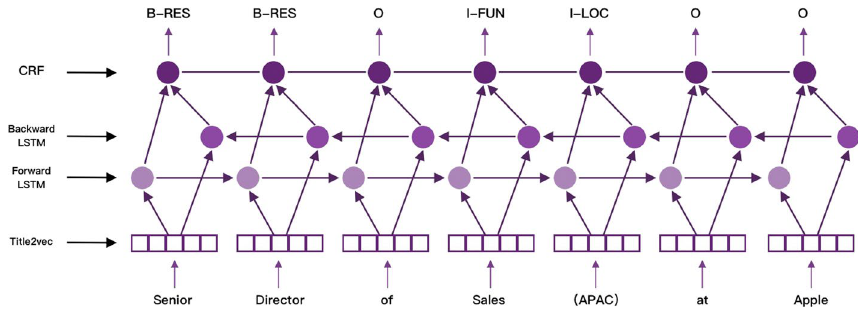
Fig. 2 Bidirectional LSTM-CRF model for occupational NER